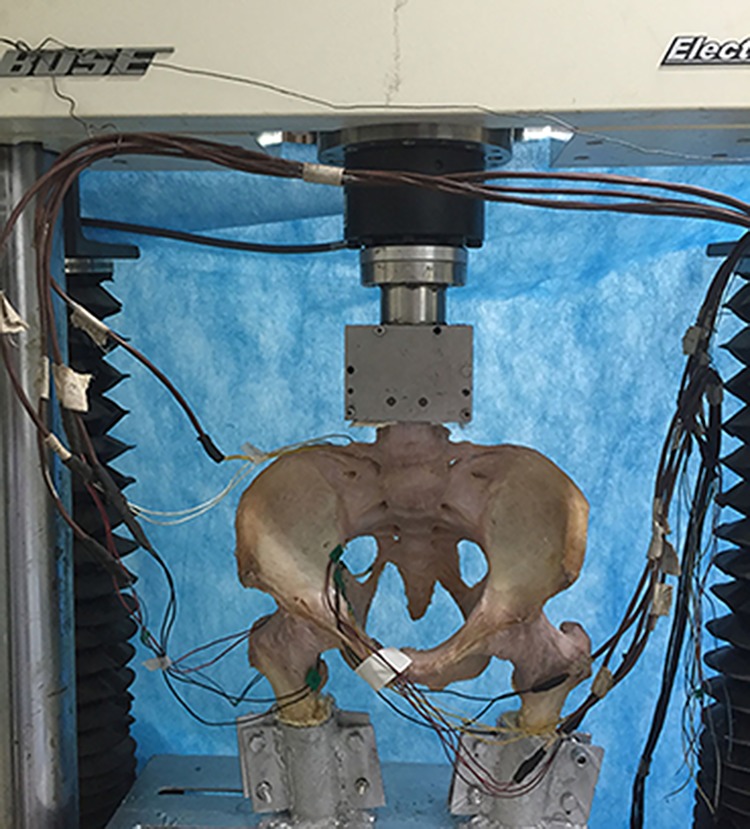
The load cell and jig used to position the pelvis and femur.The pelvis is mounted in a double-limb standing position, and axial load is applied through the fourth lumbar vertebra.